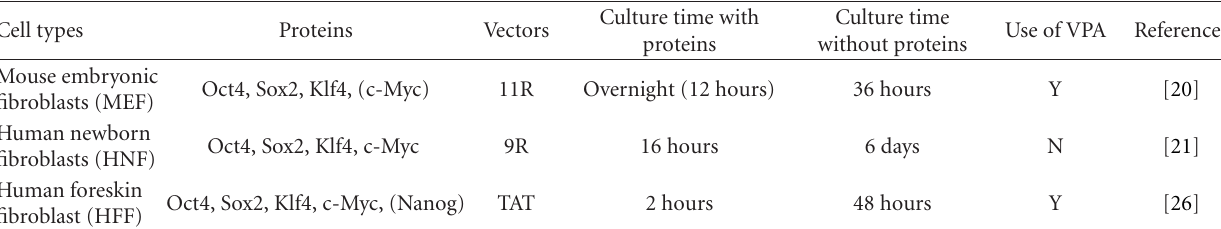
Table 1: Summary of proteins reprogramming